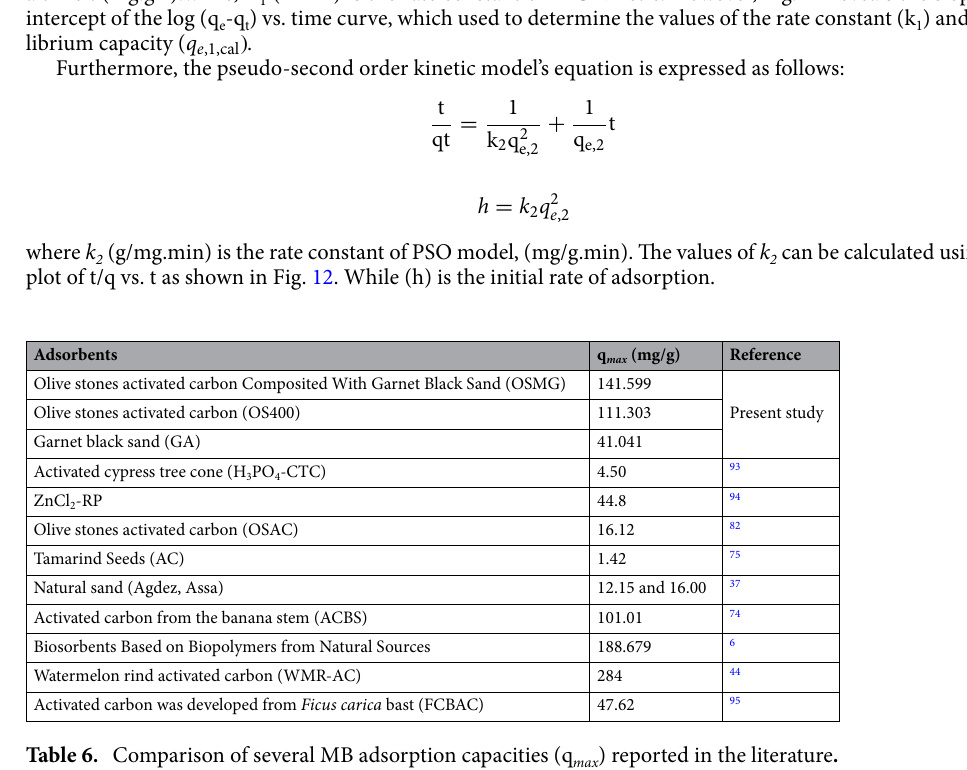
Table 6. Comparison of several MB adsorption capacities (q max ) reported in the literature .